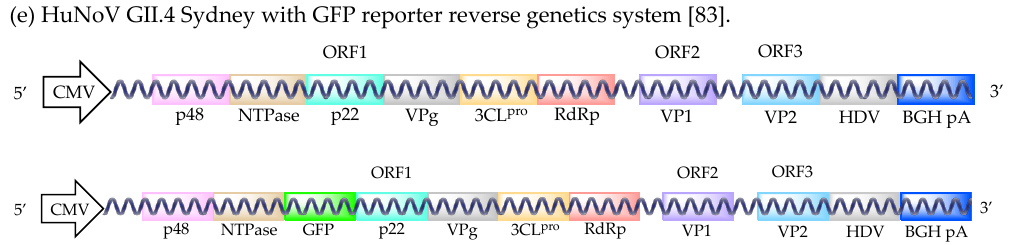
Figure 1. HuNoV reverse genetic systems. HuNoV genomic and subgenomic RNAs ( a ). HuNoV GI.1 Norwalk virus and GII.3 U201 two plasmid reverse genetic systems ( b ). HuNoV GI.1 Norwalk virus reverse genetics system ( c ). HuNoV GII.3 U201 with GFP reporter reverse genetics system ( d ). HuNoV GII.4 Sydney with GFP reporter reverse genetics system ( e ). Abbreviations: T7 polymerase promoter sequence (T7), hepatitis delta virus ribozyme (HDV), T7 terminator sequence (T7 term), human elongation factor-1 alpha promoter sequence (EF-1 α ), cytomegalovirus promoter sequence (CMV), bovine growth hormone polyadenylation signal (BGH pA).